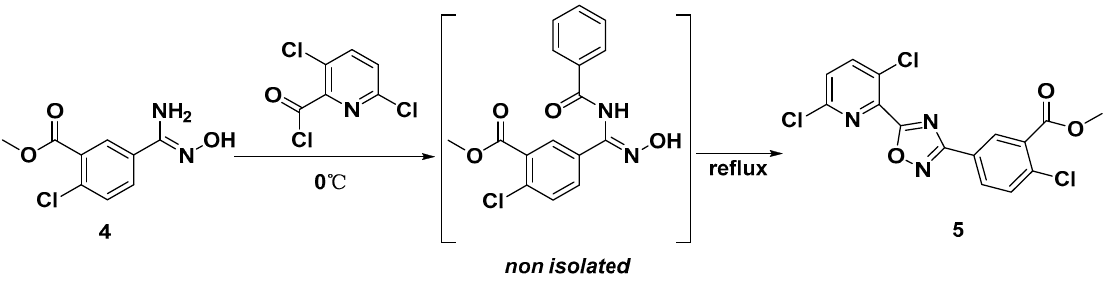
Table 1. Effects of reaction conditions on the synthesis of the intermediate 3